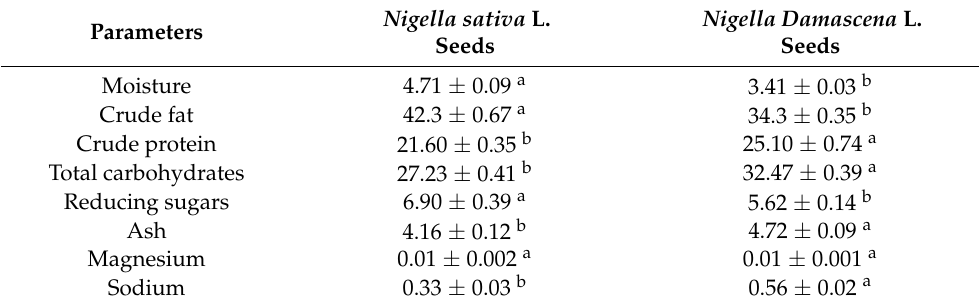
Table 2. Nutrient contents of Nigella sativa L. and Nigella damascena L. seeds (%).